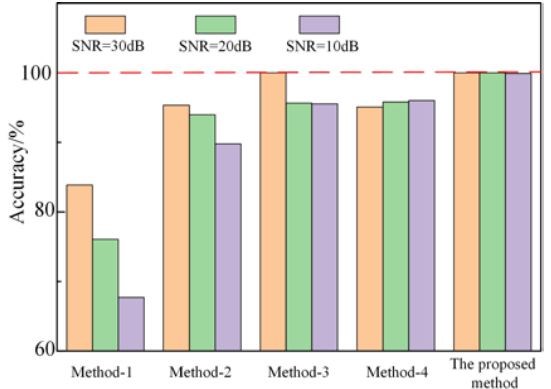
Figure 15. Test results of different methods under different noise intensity.